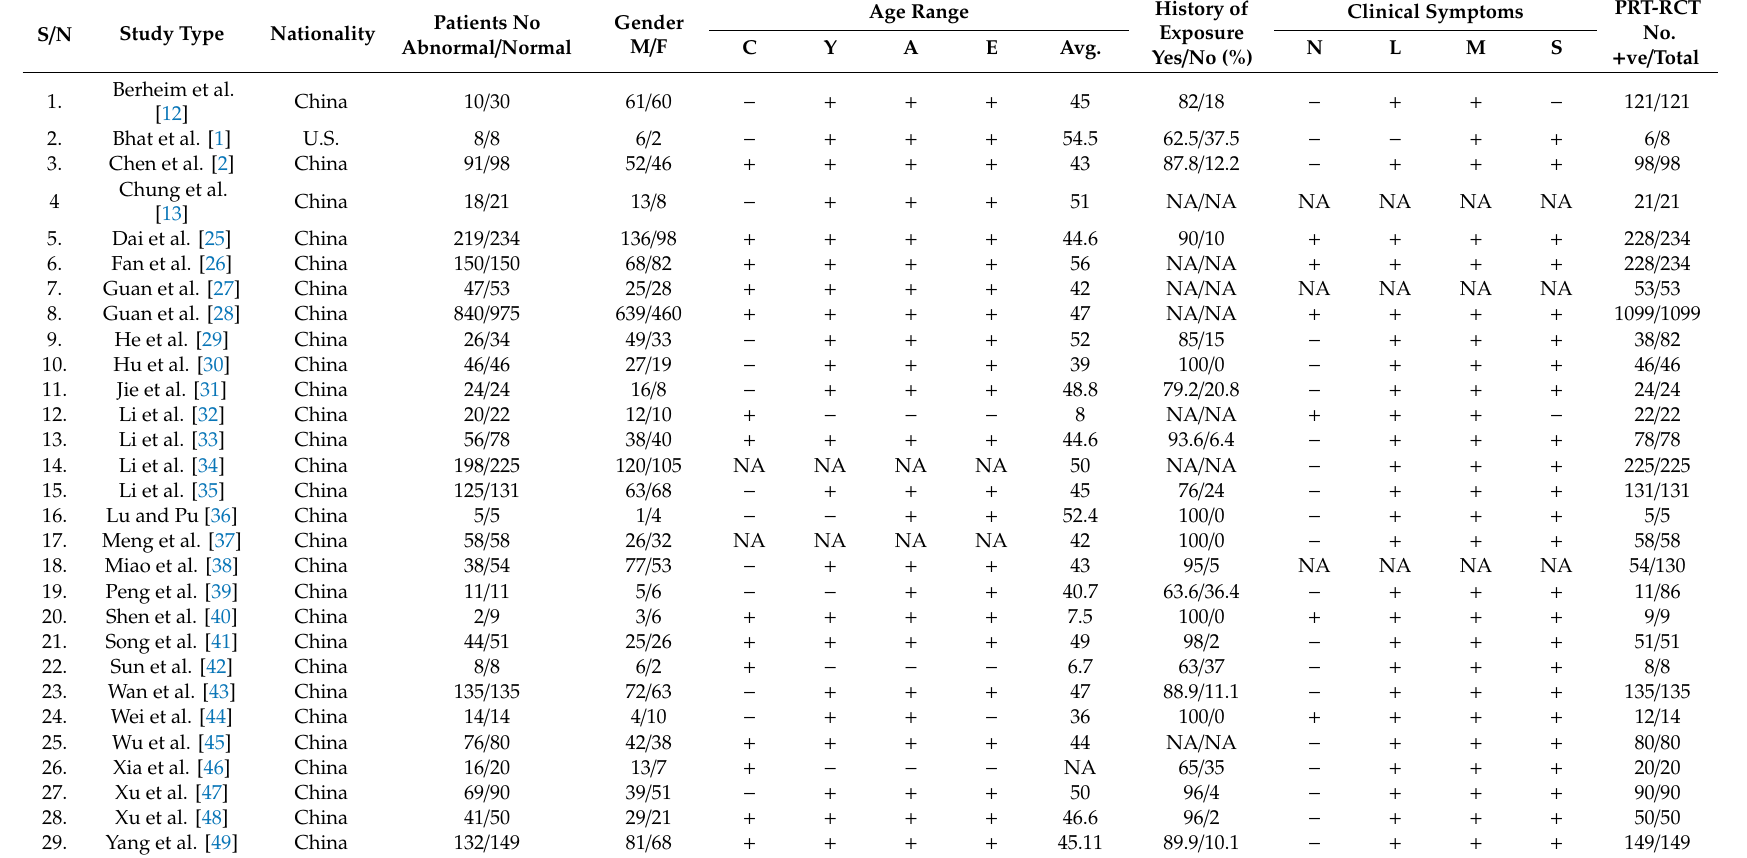
Table 1. Extraction table with biodata information, clinical symptoms of all eligible